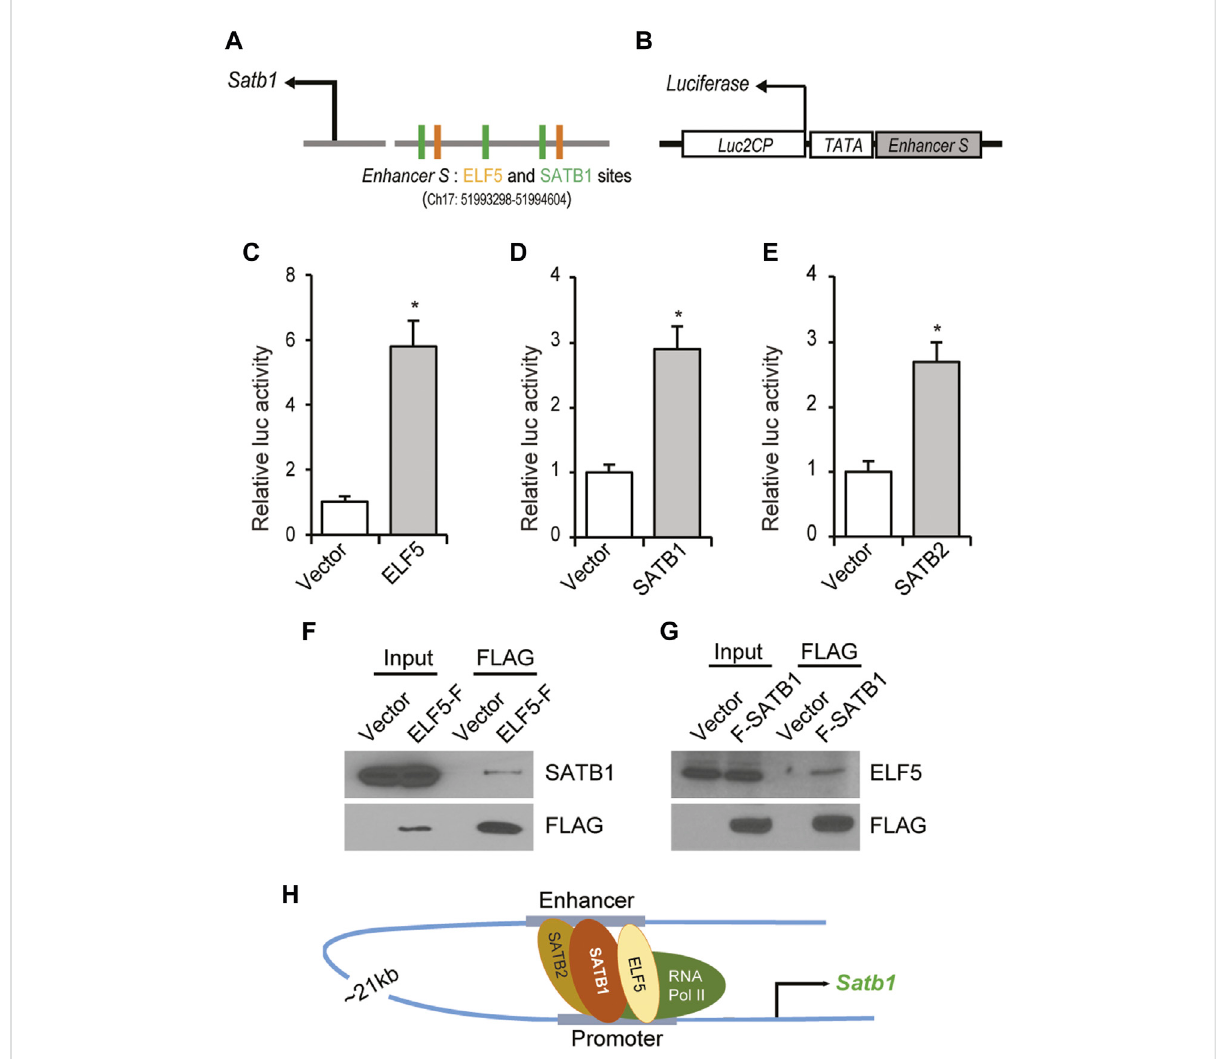
FIGURE 8 ELF5-SATB1 interaction within the enhancer S . (A) Schematic diagram showing the TFBSTools-detected two ELF5 binding sites near SATB1 motifs in mouse Satb1 enhancer sequence. (B) An enhancer-reporter construct was prepared by cloning 1.5 Kb of enhancer S upstream of a minimal TATA promoter within the Luc2CP fi re fl y luciferase vector. (C – E) , Ectopic expression of ELF5, SATB1 or SATB2 in Rcho1 rat TS cells signi fi cantly upregulated the promoter-reporter activity. Furthermore, co-immunoprecipitation of either ELF5 or SATB1 with Rcho1 nuclear proteins demonstrated that SATB1 interacts with ELF5 in trophoblast cells (F,G) . Taken together, we propose a model of ELF5-SATB interaction that regulates Satb1 expression inthetrophoblaststem-state (H) .Luciferaseassaydata areexpressedas mean± S.D.*, p < 0.05( n =3).ELF5-F,ELF5 with C-terminal FLAG tag; F-SATB1, SATB1 with N-terminal FLAG